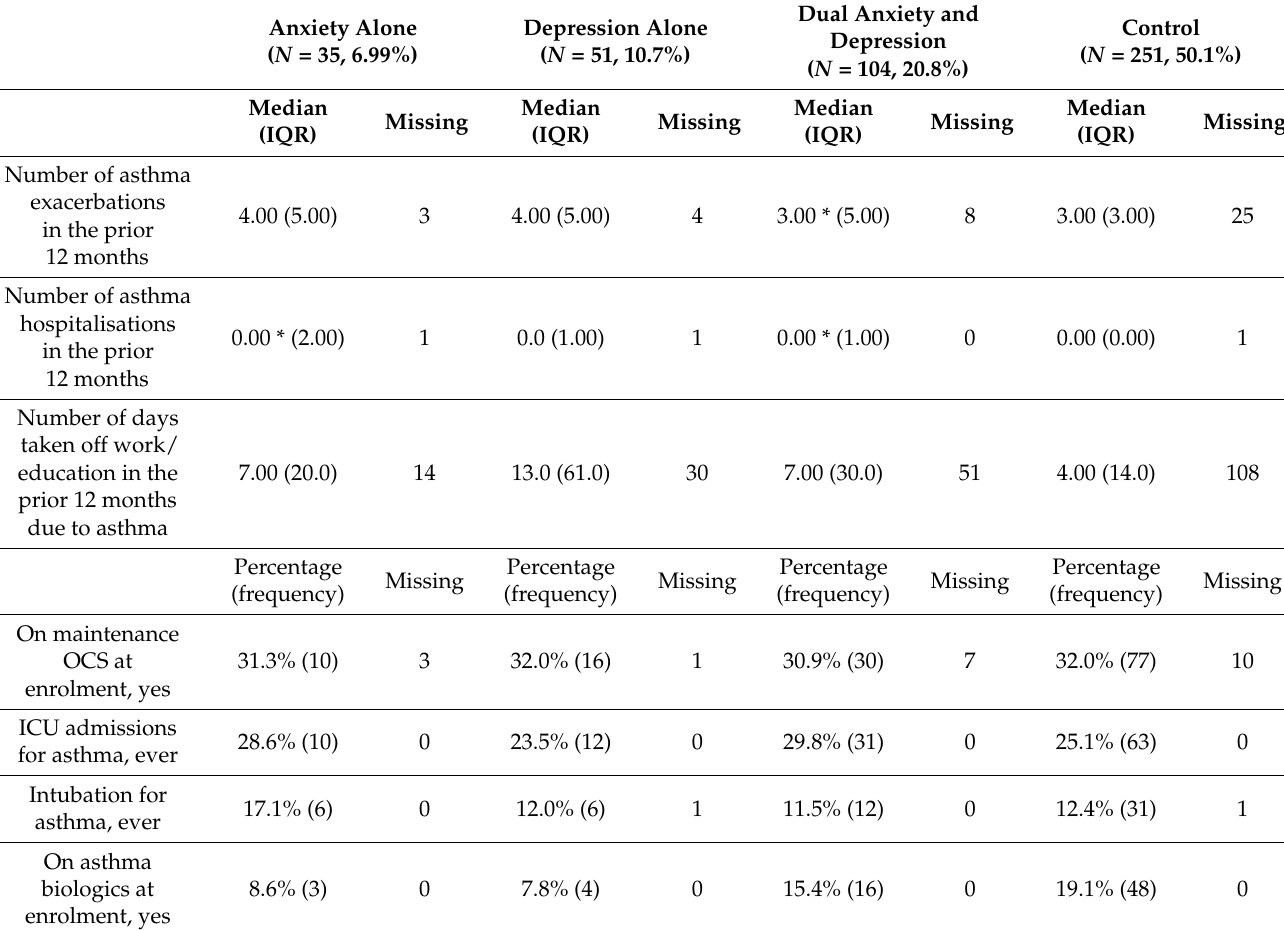
Table 3. Asthma healthcare utilisation and outcomes of WATCH patients by clinical diagnoses of psychological